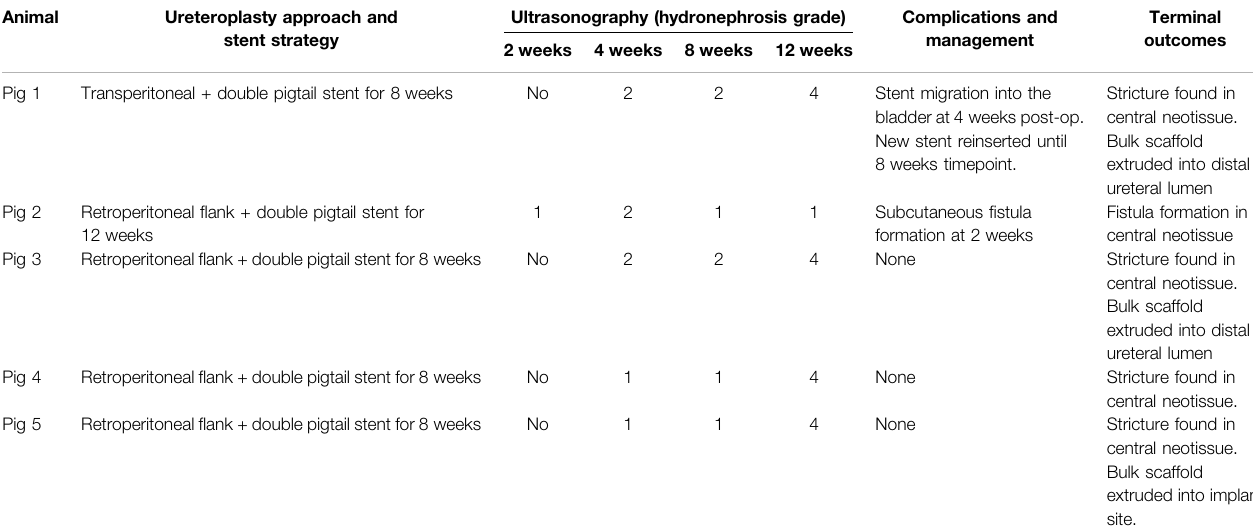
TABLE 1 | Surgical Outcomes of Tubular Ureteroplasty. Representative data from Pigs 1 – 5.